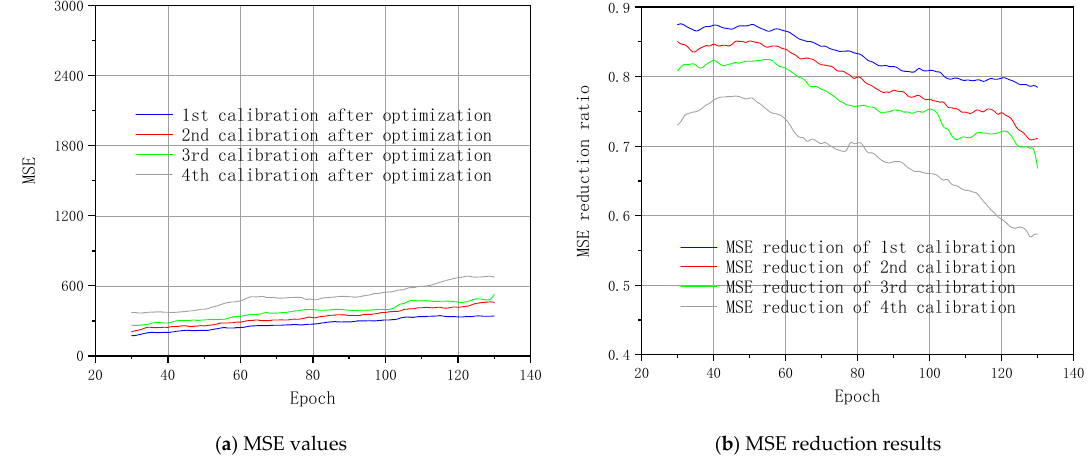
Figure 10. MSE curves regarding FEA calibration after optimization.